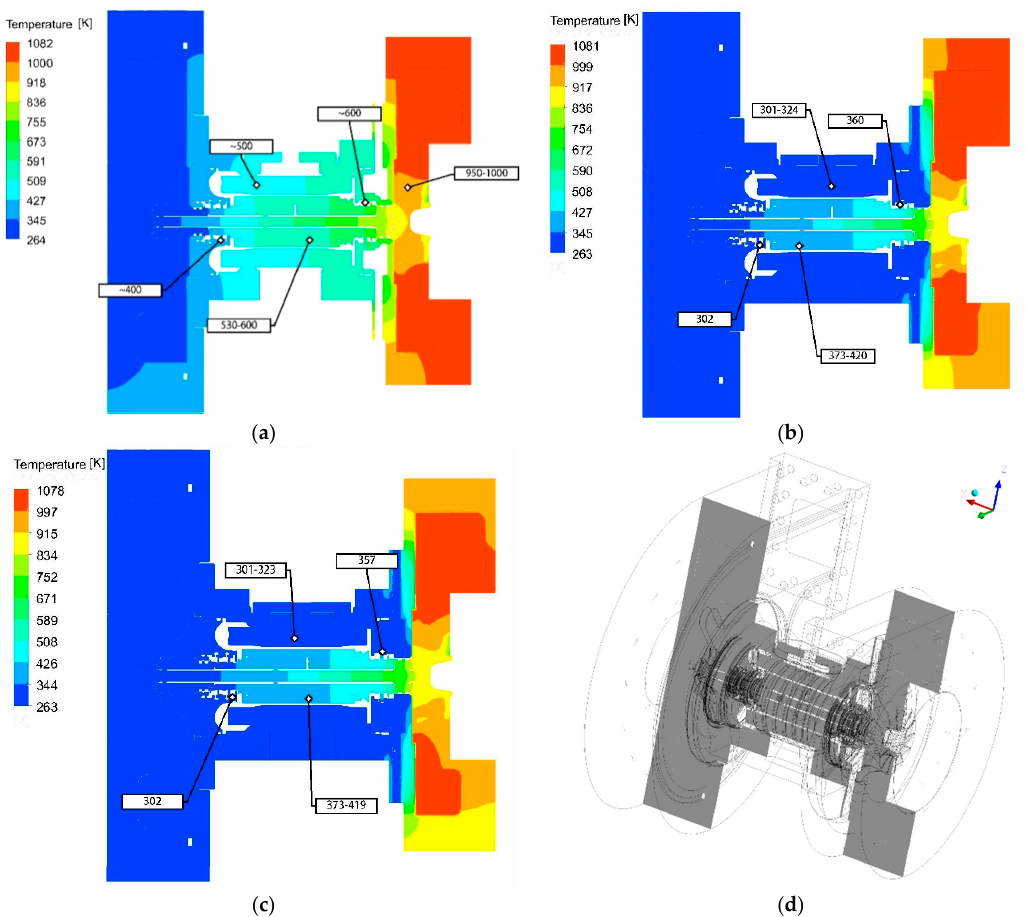
Figure 5. ( a – c ) MGT temperature profiles for the cases: no cooling used, with cooling oil and water used but no heat transfer to ambient allowed and with cooling oil and water and heat transfer to ambient allowed ( d ) Measurement